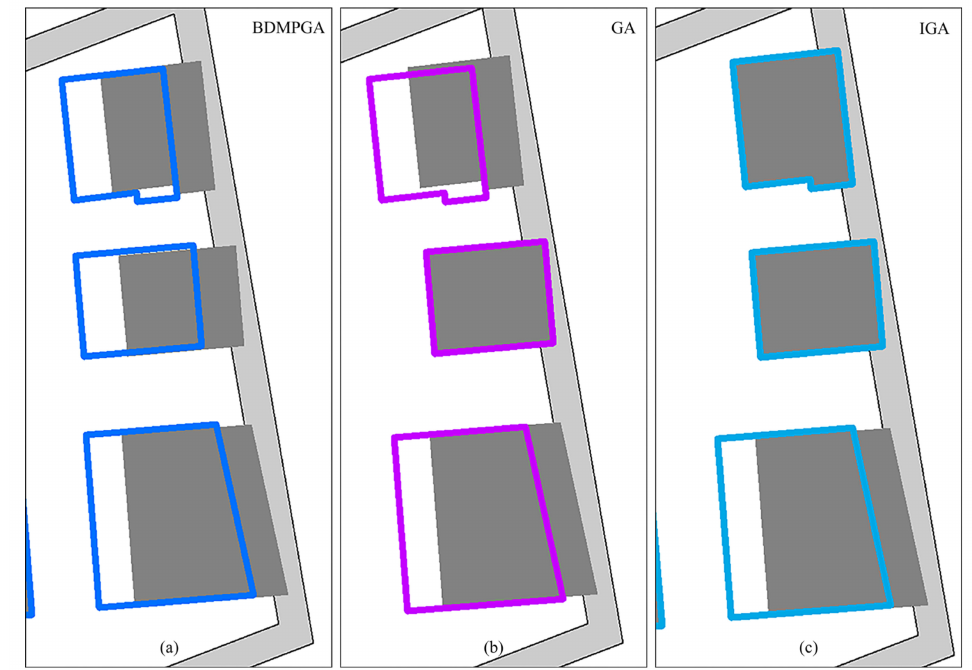
Figure 9. Contrast in detail using the proposed BDMPGA and the other two methods. ( a ) Result of linear arrangement and distribution pattern of buildings using BDMPGA; ( b ) Result of linear arrangement and distribution pattern of buildings using GA; ( c ) Result of linear arrangement and distribution pattern of buildings using IGA.